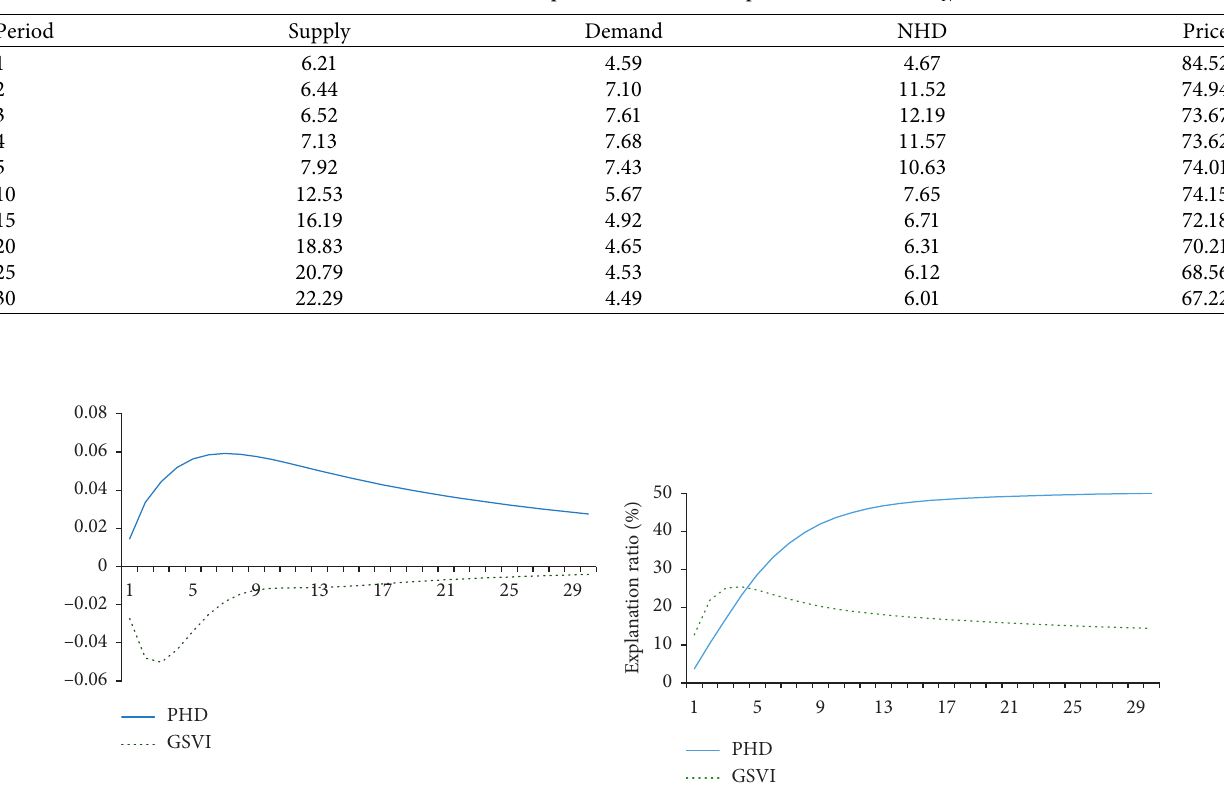
Table 8: Results of variance decomposition of Brent oil prices based on VAR